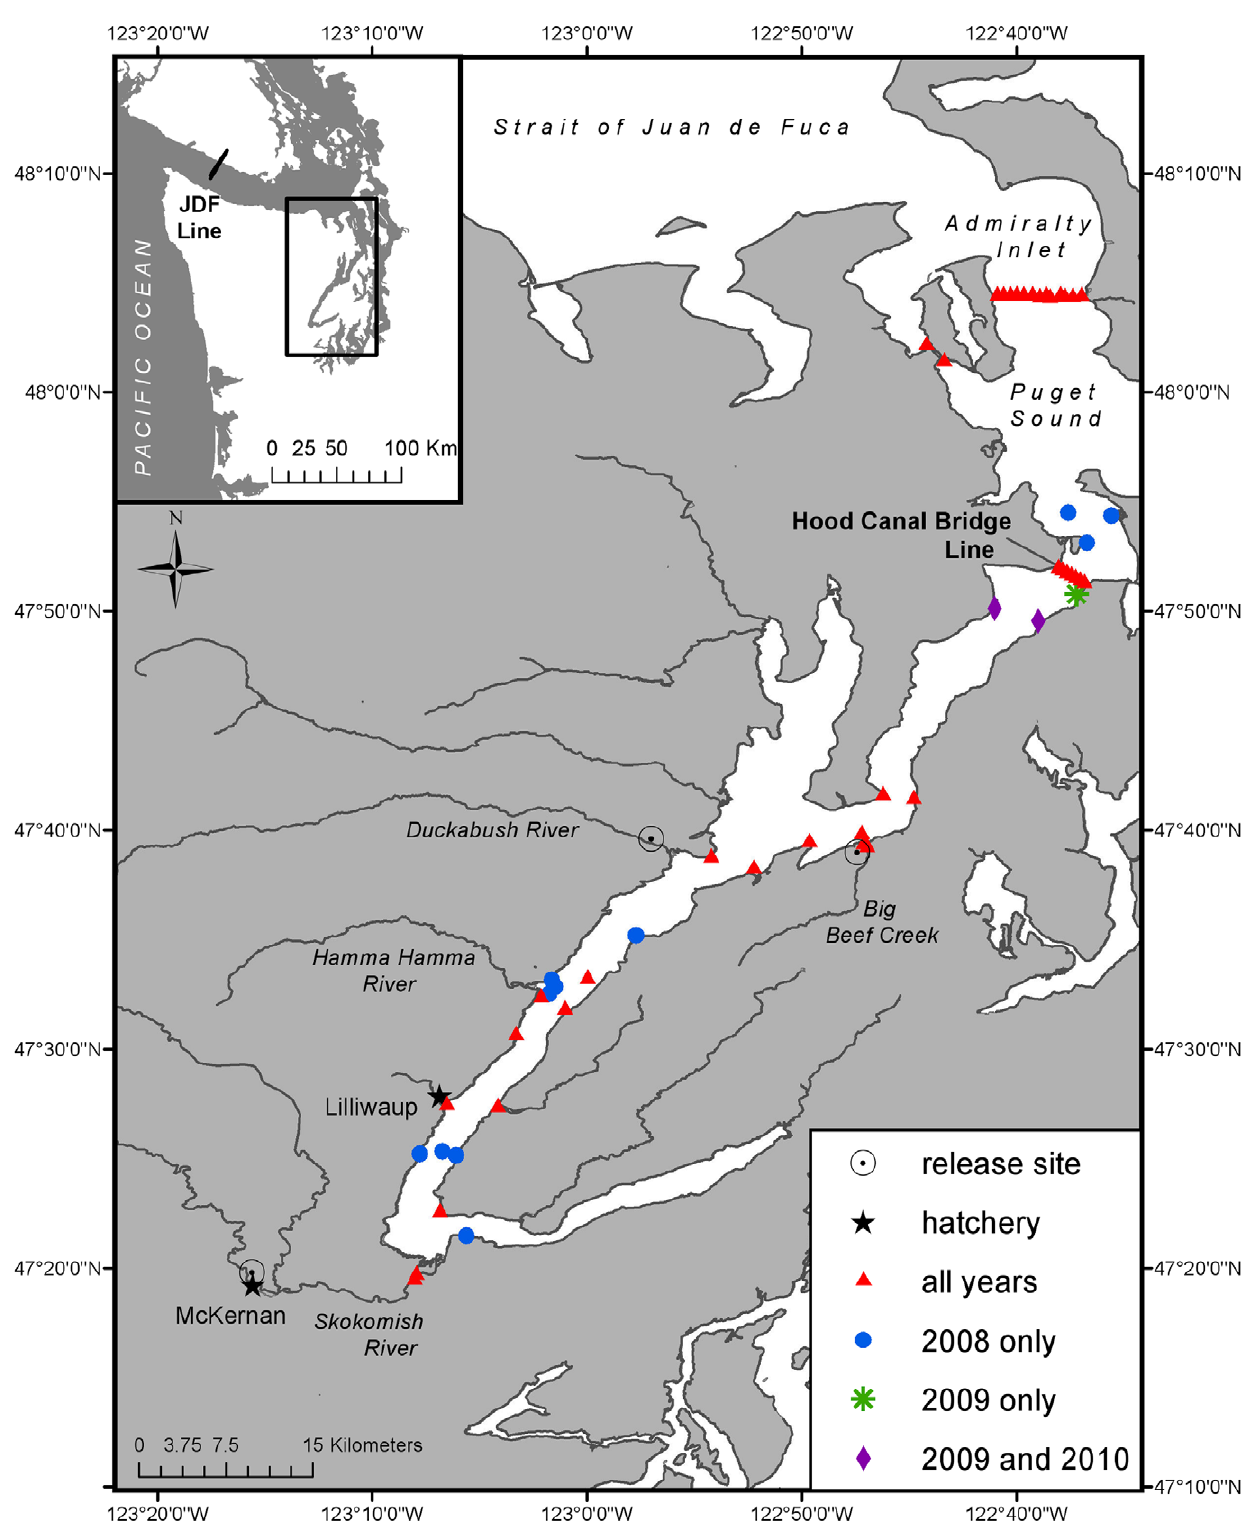
Figure 1. Acoustic receiver locations. In all three study years, one or two receivers were placed at each river mouth to detect outmigrating smolts. The Hood Canal Bridge line was comprised of seven receivers spanning Northern Hood Canal, a line of 33 receivers was deployed across the Strait of Juan de Fuca at Pillar Point, and a line of 13 receivers was deployed in Admiralty Inlet. Additional receivers were placed throughout Hood Canal and Puget Sound to compare migration behavior of wild and hatchery-reared smolts.